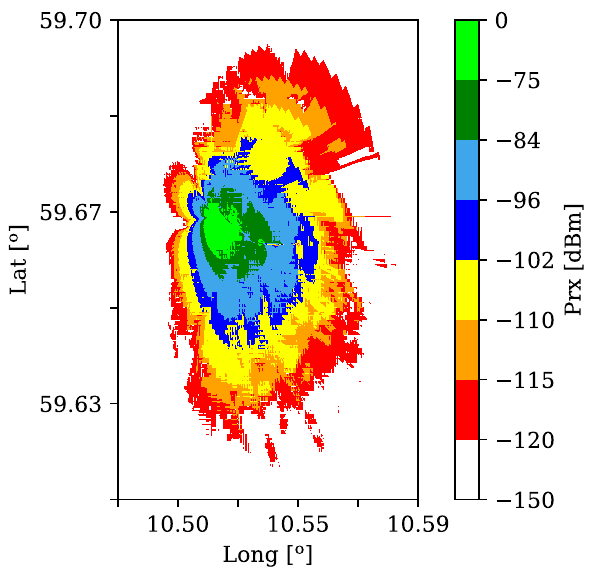
Figure 8. Coverage area of the considered scenario.